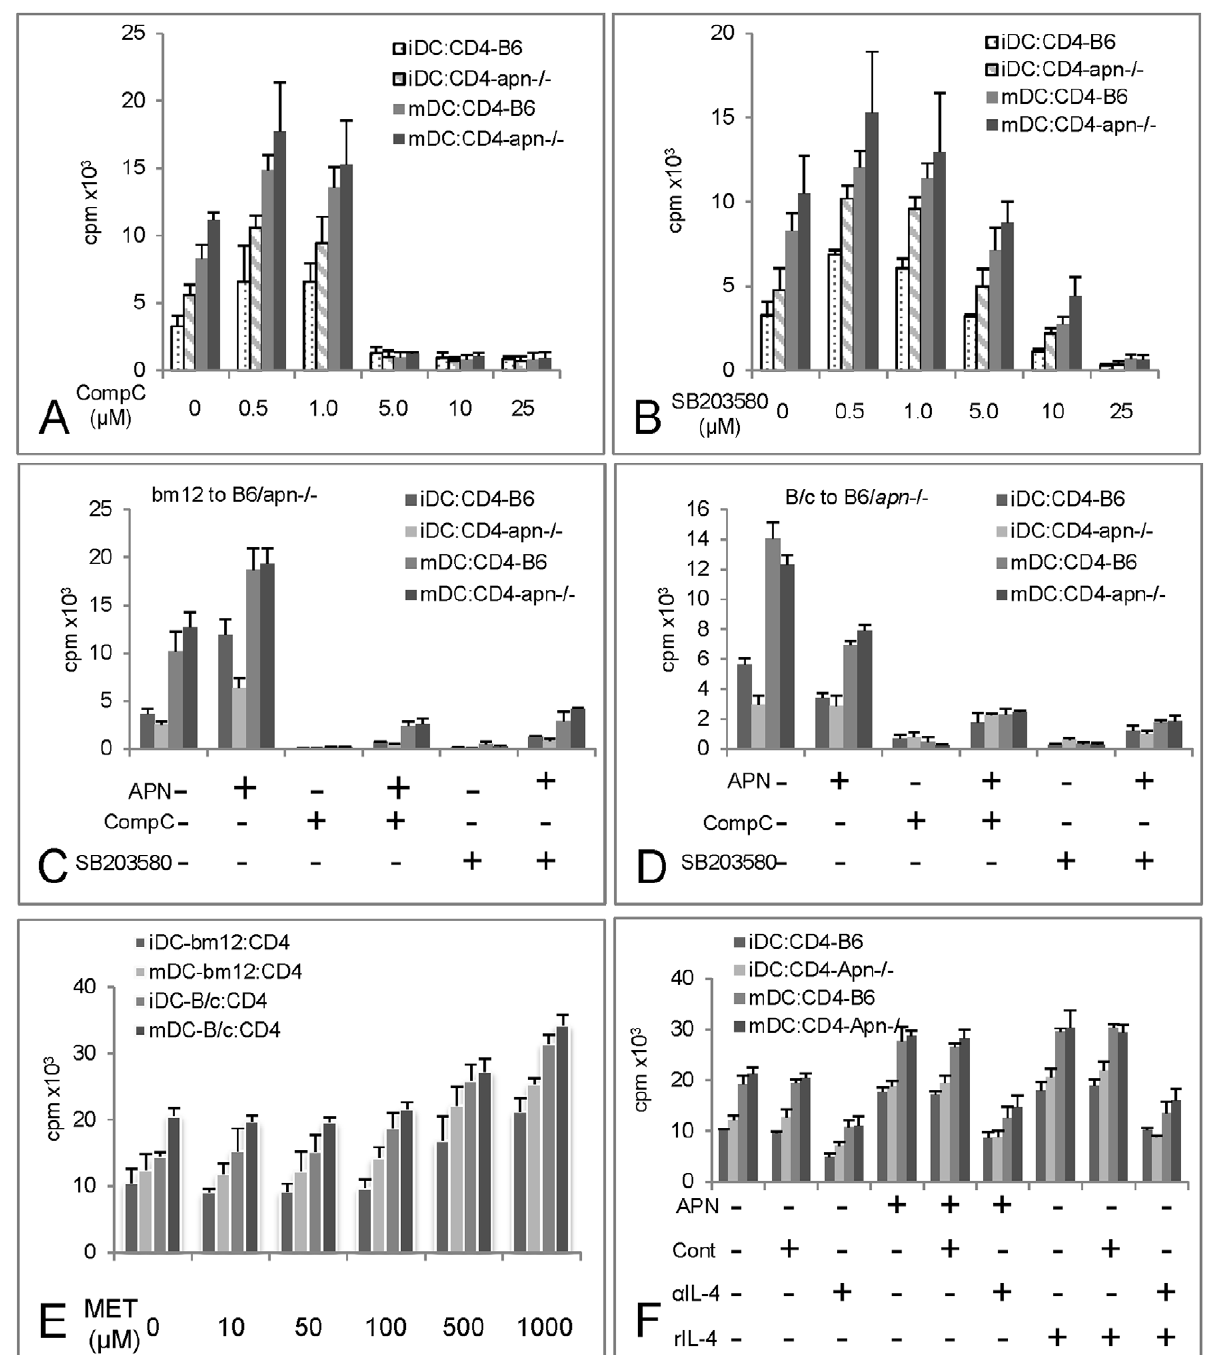
Figure 2. Effects of adiponectin and its signaling pathways on dendritic cell (DC) induced T cell function. Bone marrow derived dendritic cells from bm12 mice were used as stimulator cells and CD4 + T cells from B6 or Apn–/– mice as responder cells. Cell proliferation was measured by 3 H-thymidine incorporation. Immature DCs were treated with LPS for an additional 24 h to induce maturation. n=4 and one representative graph is presented. The APN signaling inhibitors, Compound C (CompC) for AMPK (A) and SB203580 for p38 MAPK (B) were added at different concentrations. The effect of APN and signaling inhibitors on T cell proliferation in MLRs of DCs from bm12 and T cells from apn–/– was measured. APN (5 m g/ml) was added to MLRs for 24 h in the presence or absence of CompC or SB203580 (C). Similarly the compounds were tested in MLRs with DCs from Balb/c (B/c) mice (D). Effect of Metformin (MET) on T cell proliferation was assessed. DCs were obtained from either bm12 or B/c and the T cells were isolated from B6. MET was added to MLRs and the T cell proliferation was measured as above (E). The effect of IL-4 on APN induced proliferation was evaluated. APN (5 m g/ml), anti-IL-4 antibody ( a IL-4, 50 m g/ml) and mouse recombinant IL-4 (rIL-4, 50 ng/ml) were added to the MLRs and T cells proliferation were measure as described as above (F).